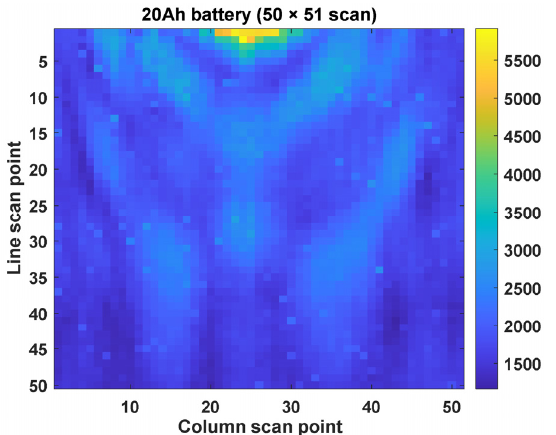
Figure 5. Energy spectrum of surface scanning UGW signal of lithium-ion battery.